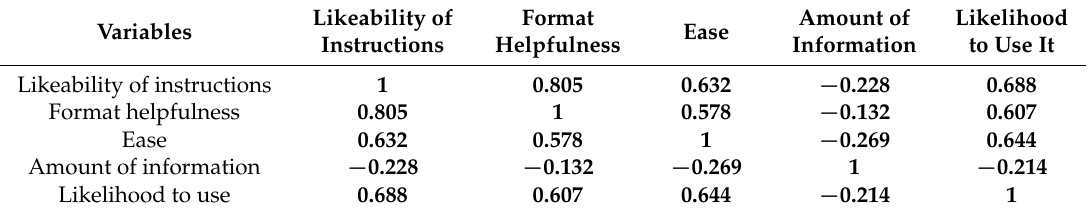
Table A1. Pearson’s correlation matrix for wheat recipes’ validation ( n =